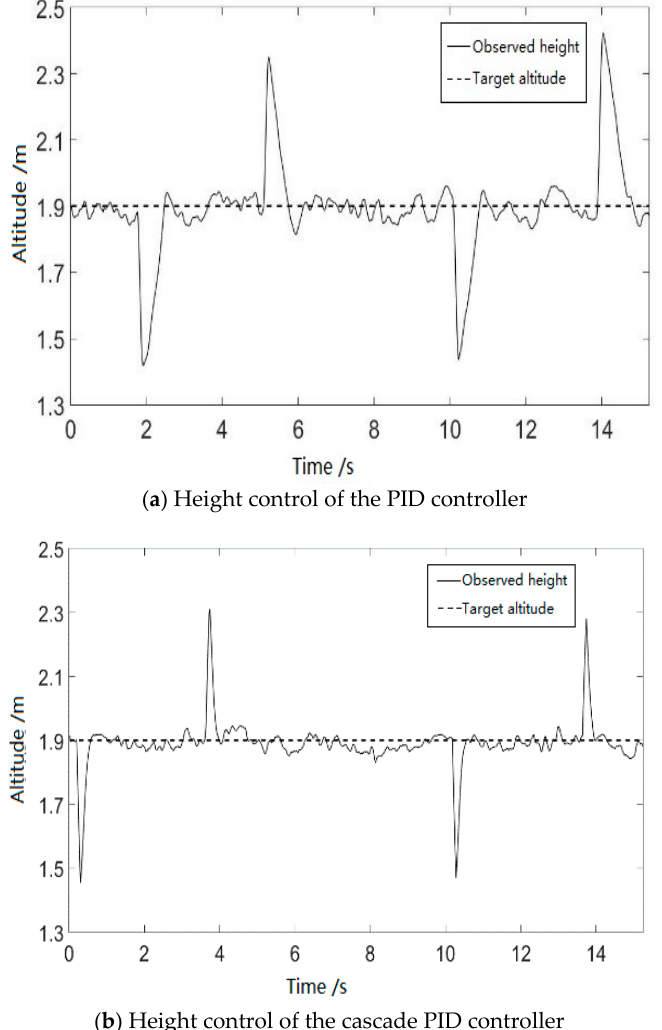
Figure 12. Comparison of the cascade PID height controllers for the quadrotor above a cardboard box on the ground.